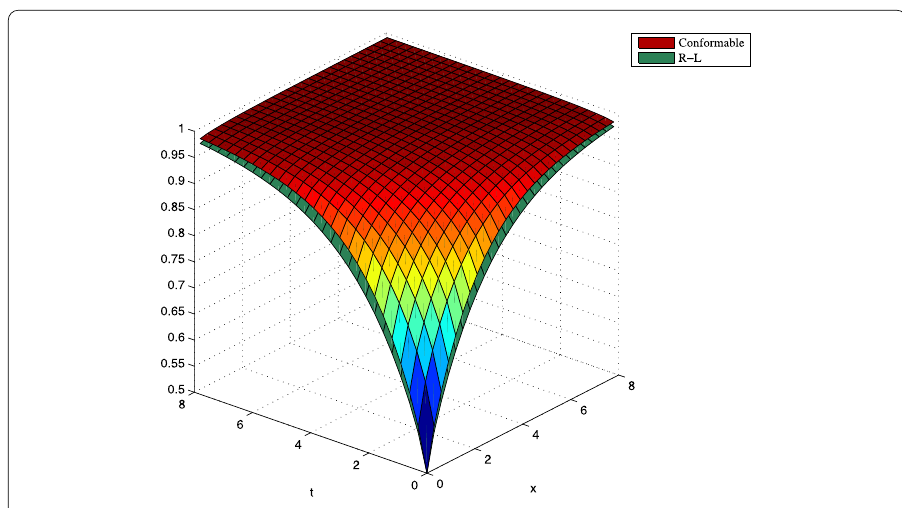
Figure 1 Exact solutions u 1 ( x , t ), u 5 ( x , t ) of fractional Cahn–Allen equation at α = 0.8, γ = 1, c = 1, k =